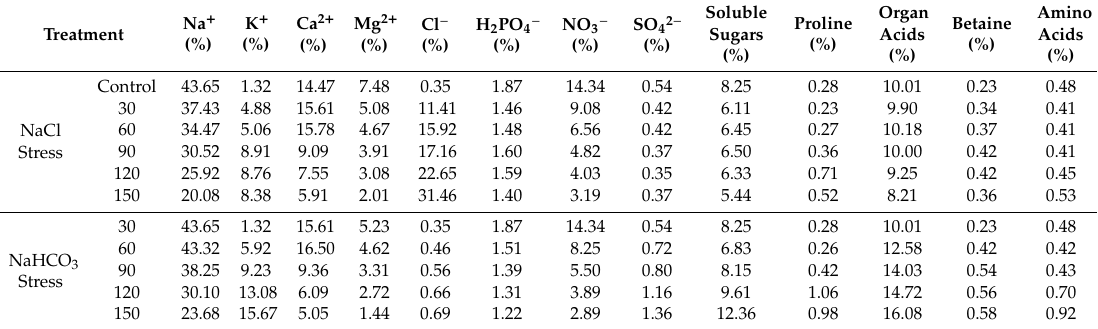
Table 2. Contribution of each solute molarity to the total determined osmoregulators molarity in common bean leaves under neutral salt and alkaline salt stresses. Percentages were calculated from the mean values of each solute.